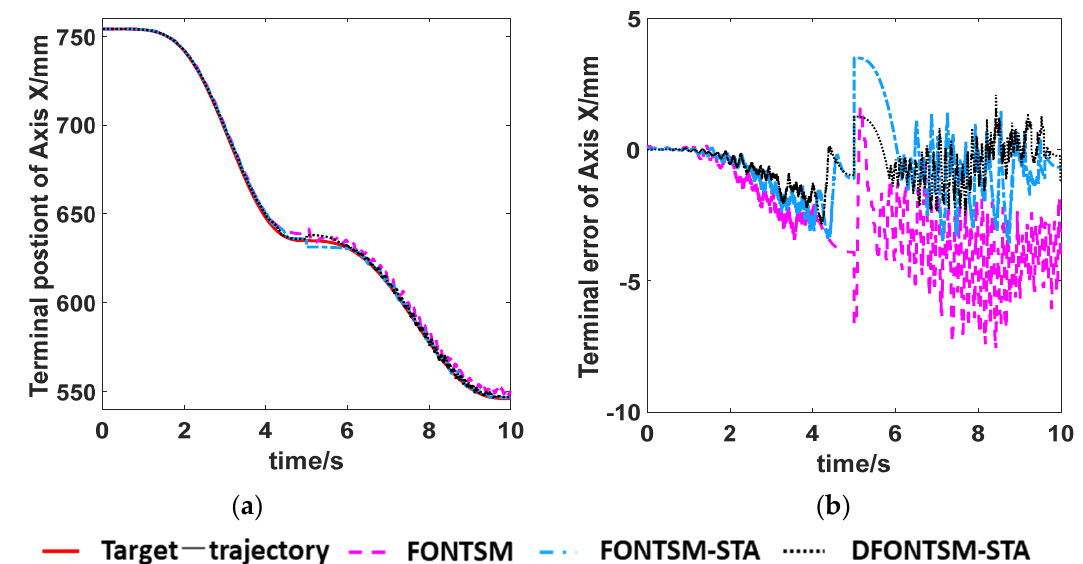
Figure 15. Terminal trajectory and its tracking error. ( a ): terminal trajectory on the X axis; ( b ): terminal tracking error on the X axis.